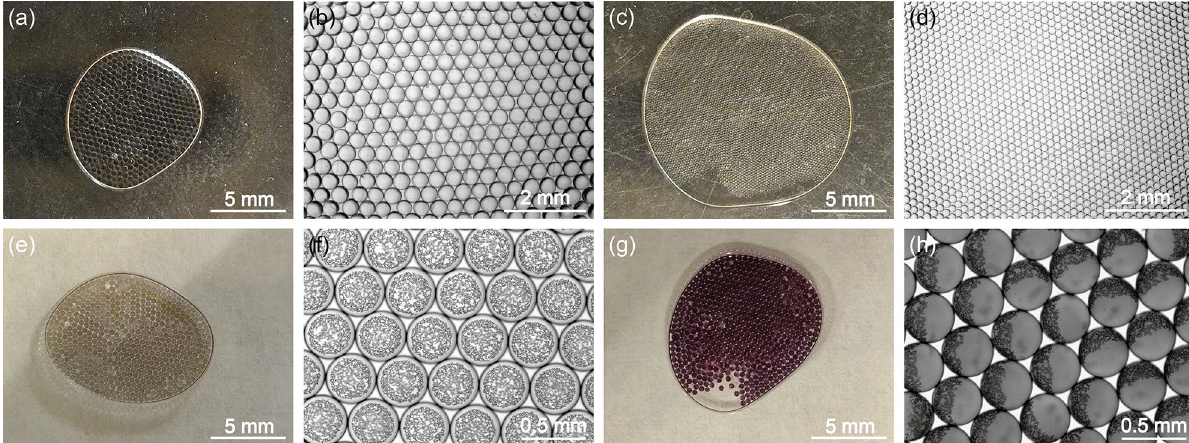
Figure 10. Controlled synthesis of microgels: ( a – d ) Smartphone ( a , c ) and microscope ( b , d ) images of two sizes of polyacrylamide microgels prepared from 20 µL mixtures with different pipette tips. ( e , f ) Droplets with gelation precursors and gold reduction sources before gelation. In the liquid phase droplets, the reduced gold will precipitate to the bottom of the droplets because of its higher density. The droplets are UV crosslinked to synthesize the capped polyacrylamide/gold composite microgels in ( g , h ). The UV gelation process will also expedite gold reduction and the in situ formed polyacrylamide network confines the growth of reduced gold to produce ( g ) wine red microgels filled with gold nanoparticles. Previously precipitated gold at the bottom of each liquid droplet will be fixed in place to eventually prepare ( h ) microgels with gold caps. Images of ( a , c , e , g ) are taken by smartphone while images of ( b , d , f , h ) are taken by a table-top